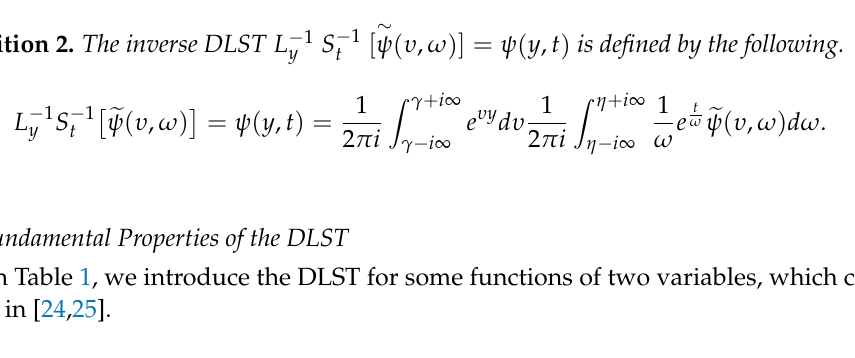
Table 1. The DLST for some functions of two variables